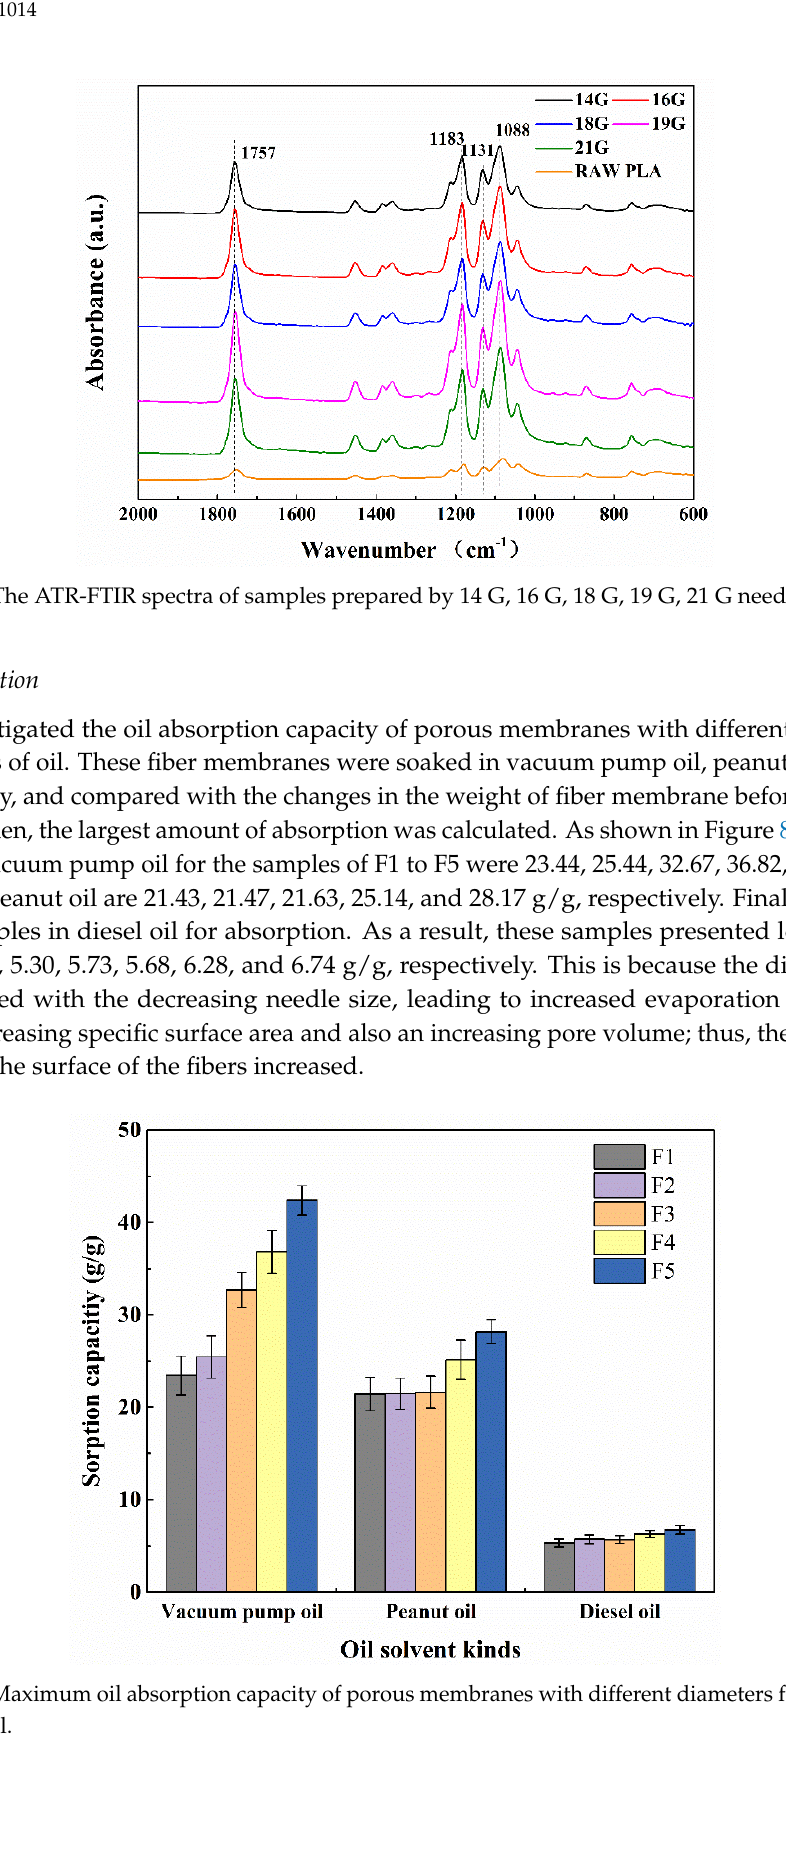
Figure 8. Maximum oil absorption capacity of porous membranes with different diameters for different kinds of oil.